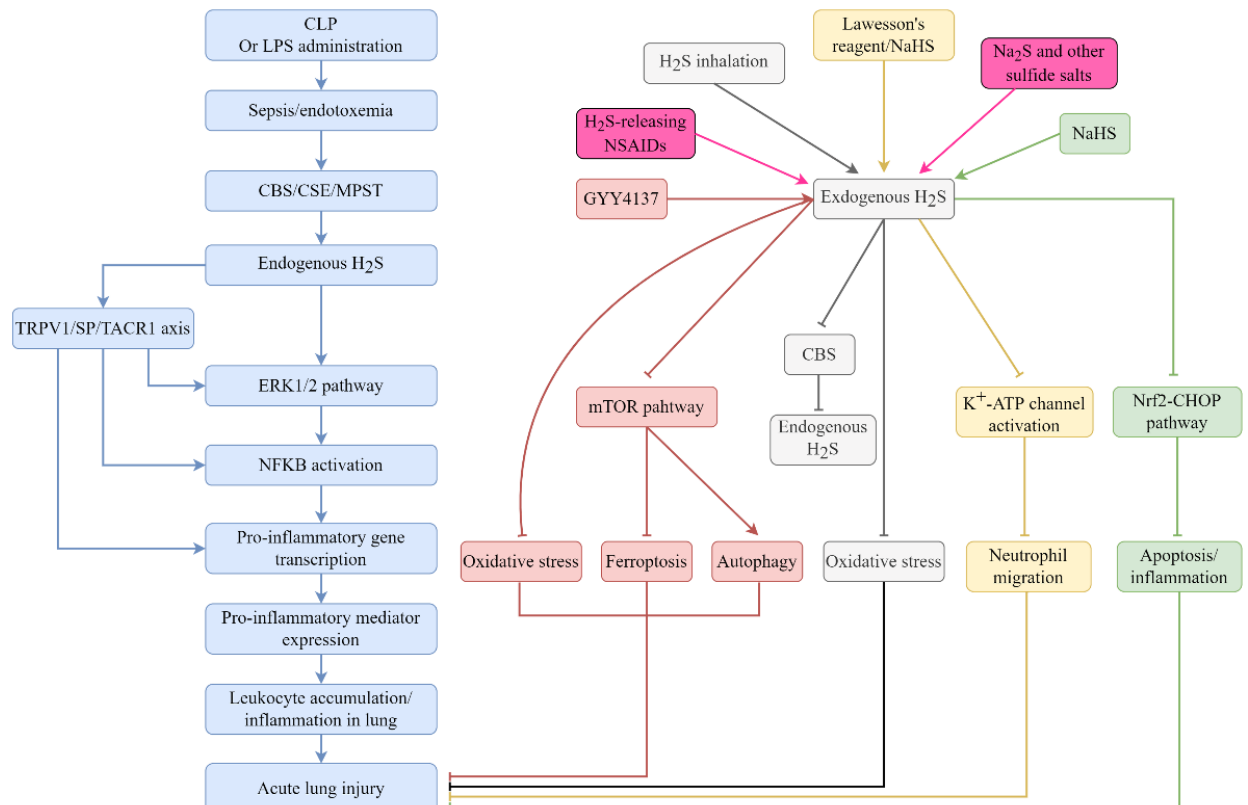
Figure 2. Overview of the role of H 2 S in sepsis/endotoxemia-induced acute lung injury. The induction of sepsis or endotoxemia in animals leads to an increase in the expressions of CBS, CSE and MPST, and further results in an upregulation in host-derived H 2 S. Subsequently, endogenous H 2 S imbalance dysregulates several inflammatory pathways and further causes remote lung injury. In contrast, the supplement of exogenous H 2 S may be therapeutically advantageous as it protects animals against lung injury in sepsis. Abbreviations: cecal ligation and puncture (CLP), lipopolysaccharide (LPS), transient receptor potential vanilloid type 1 (TRPV1), substance P (SP), tachykinin receptor 1 (TACR1), extracellular signal-related kinases (ERK), mechanistic target of rapamycin